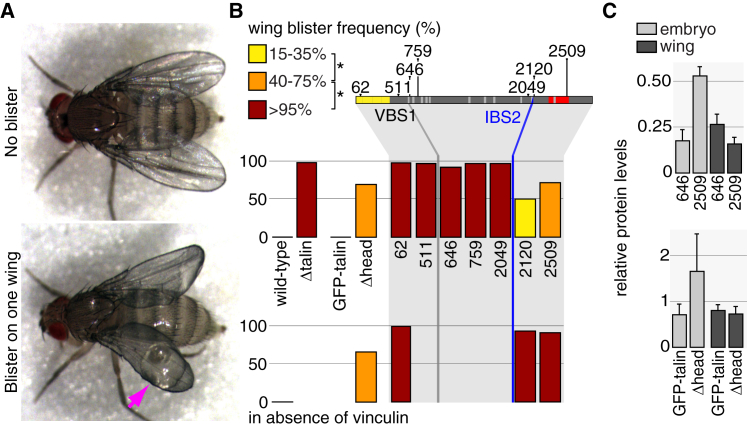
Both Talin Head and IBS2 Are Used for Wing Adhesion(A) Representative pictures of newly hatched flies with normal wings (top) or one wing with a blister (bottom; pink arrow).(B) Percentage of blistered wings in flies with homozygous mutant clones for the mutants indicated (for all mutants, see Figure S3), from ≥100 flies/mutant. Bar colors show four statistically distinct categories (∗p < 0.01). Flat bars (horizontal lines) indicate no defect. Genotypes not analyzed do not have a bar.(C) Phenotypic differences between muscle and wing are not explained by differences in protein levels, determined by western blotting of talin646 and talin2509 (top histogram) and talin site-directed mutants (bottom histogram) in embryos (light gray) or pupal wings (dark gray) heterozygous for the talin mutation. The protein levels were normalized to wild-type talin in each sample. SD is shown from two independent experiments.